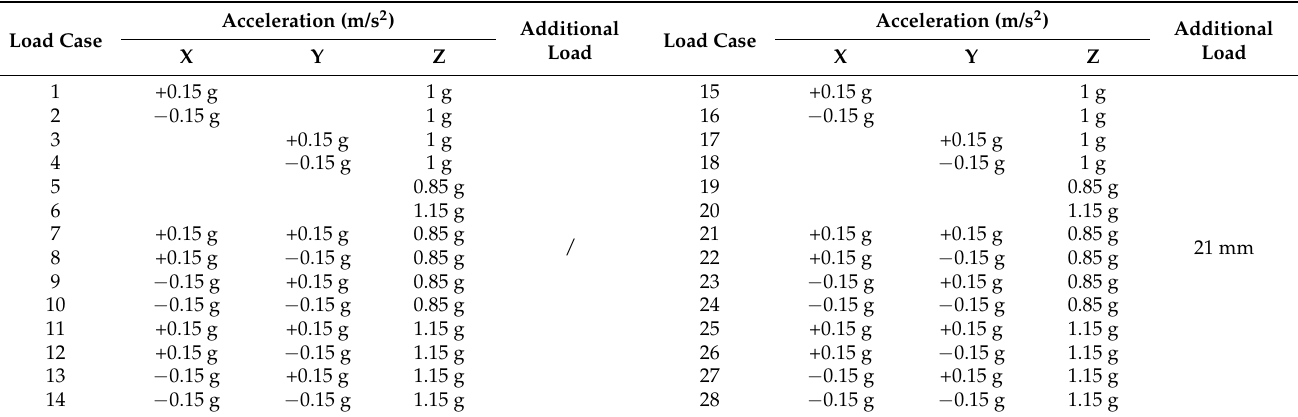
Table 1. Cyclic load cases for fatigue strength assessment.